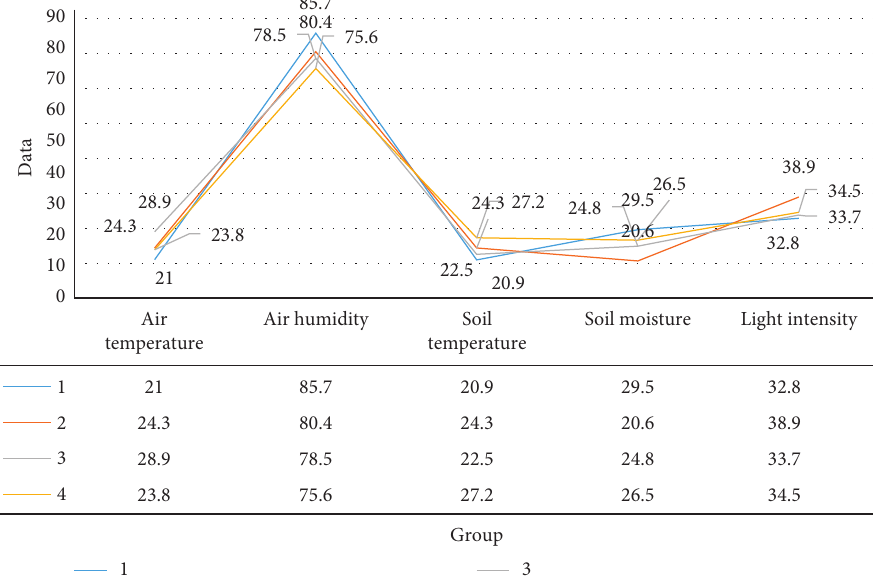
Figure 8: Sensor acquisition